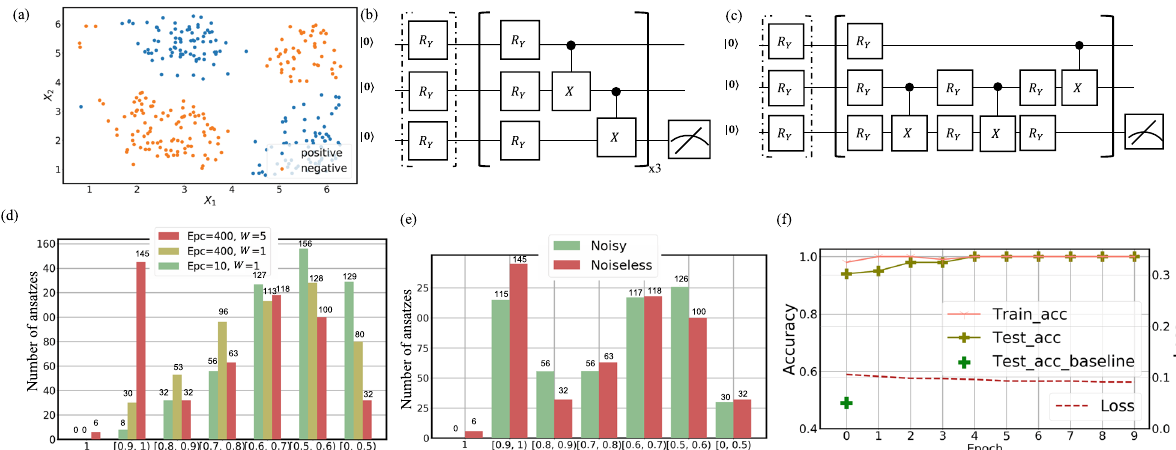
Fig. 2 Simulation results for the classi fi cation task. a The illustration of some examples in D with fi rst two features. b The implementation of the quantum kernel classi fi er for benchmarking. The quantum gates highlighted by dashed box refer to the encoding layer that transforms the classical input x ( i ) into the quantum state. The quantum gates located in the solid box refer to U l ( θ ) in Eq. (2) with L = 3. c The output ansatz of QAS under the noisy setting. d The validation accuracy of QAS under the noiseless case. The label “ Epc = a , W = b “ represents that the number of epochs and supernets is T = a and W = b , respectively. The x -axis means that the validation accuracy of the sampled ansatz is in the range of [ c , d ), e.g., c = 0.5, and d = 0.6. e The comparison of QAS between the noiseless and noisy cases. The hyper-parameters setting for both cases is T = 400, K = 500, and W = 5. The labeling of x -axis is identical to sub fi gure ( d ). f The performance of the quantum kernel classi fi er (labeled by “ Test_acc_baseline ” ) and QAS (labeled by “ Train/Test_acc ” ) at the fi ne tuning stage under the noisy